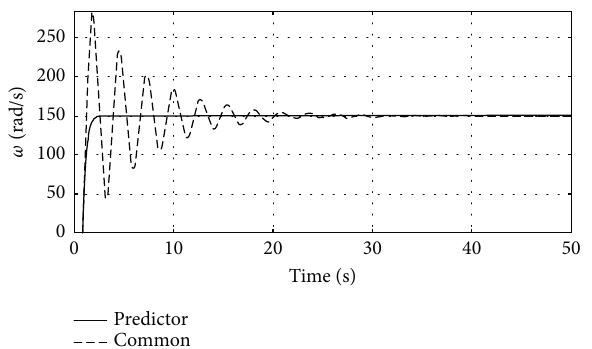
Figure 15: Comparing a predictive-based H common H controller for τ � 0 . 8s. ∞